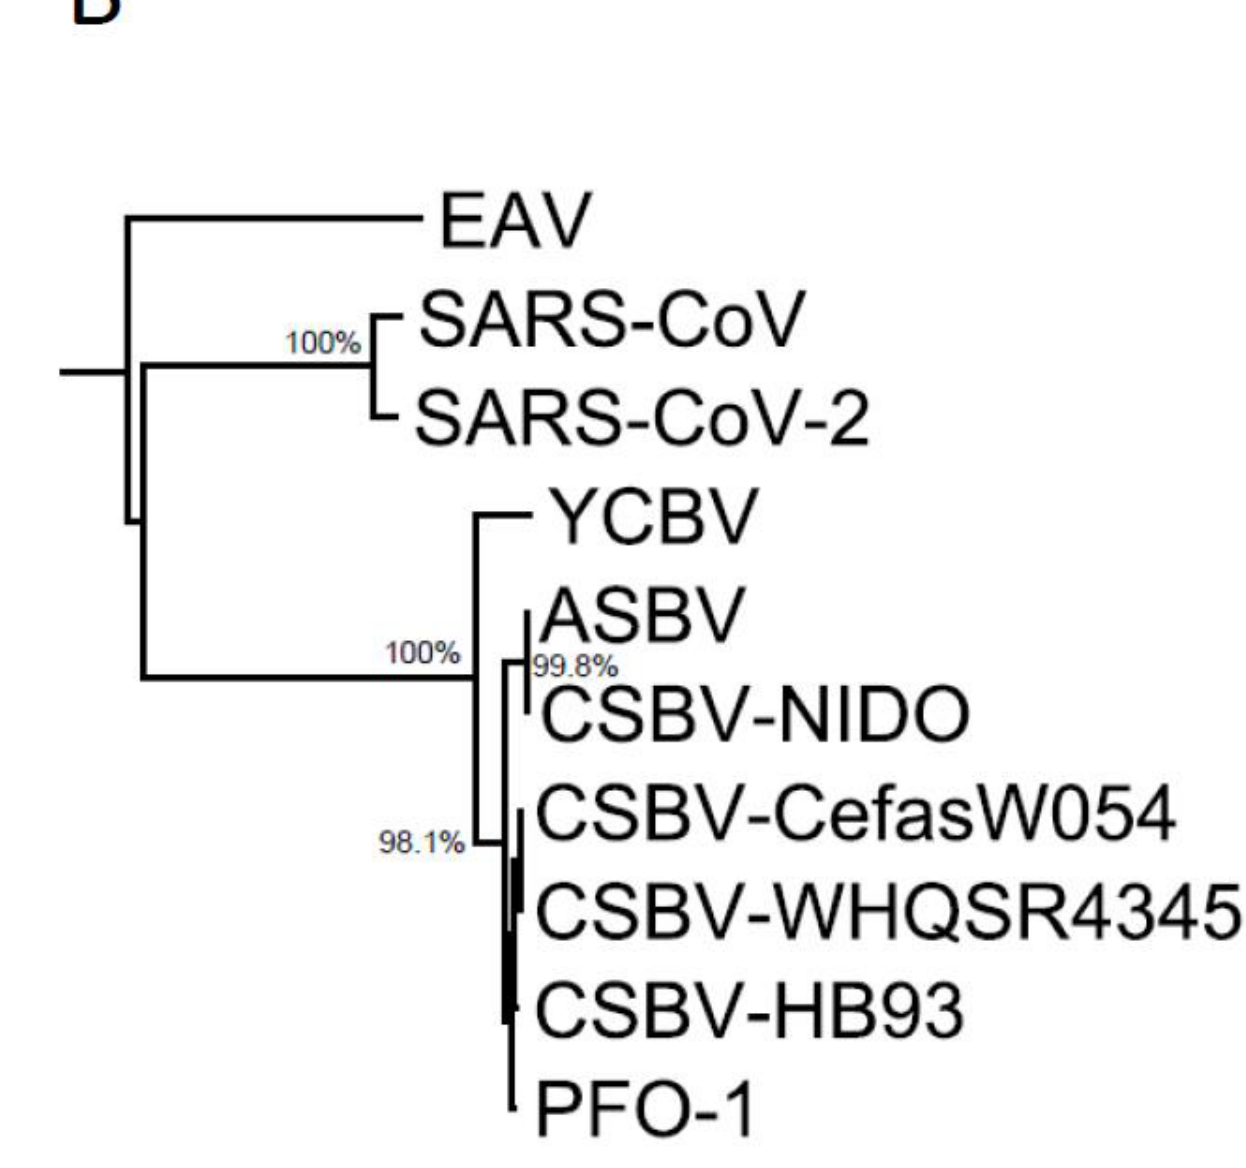
Figure 3. Cont Figure 3. Phylogeny of selected nidoviruses based on the amino acid and nucleotide sequences of the E proteins. Phylo- genetic tree based on ( A ) amino acid sequences and ( B ) nucleotide sequences, of seven members of genus Oncotshavirus (listed in Table 1) and two members of genus Betacoronavirus , lineage B (SARS-CoV and SARS-CoV-2) with Equine arteritis virus (EAV) E protein sequence GenBank accession number: NC_002532) as the outgroup to determine its root. The graph- ical editor for phylogenetic trees, TreeGraph 2 [57] was used to produce the figures. Each bootstrapping value corresponds to the branch on the same vertical level. Only the bootstrapping supports higher than 70% are marked in the phylogenetic trees. Abbreviations at the end of each sequence correspond to the virus names: ASBV = Atlantic salmon bafinivirus VT01292015-09; CSBV-NIDO = Chinook salmon bafinivirus NIDO; CSBV Cefas-W054; CSBV WHQSR4345; CSBV HB93; YCBV = Yellow catfish bafinivirus Shaoxing; PFO-1 = Pelteobagrus fulvidraco oncotshavirus-1 ZJLH18531; SARS-CoV = Severe acute respiratory syndrome coronavirus Tor2; SARS-CoV-2 Wuhan-Hu-1; and EAV = Equine arteritis virus Bucyrus.